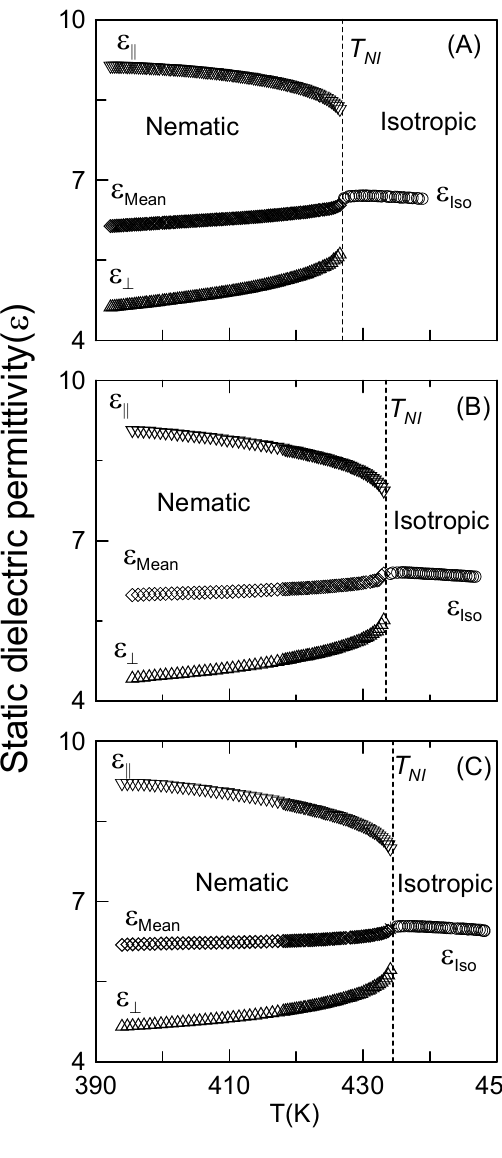
Figure 3. Static dielectric permittivity vs . temperature for ( A ) CBO11O.Py; ( B ) CBO9O.Py; ( C ) CBO7O.Py. In the nematic phase, downward triangles represent the parallel component of the static dielectric permittivity, upward triangles represent the perpendicular component and diamonds represent the mean value. Circles represent the static dielectric permittivity in the isotropic